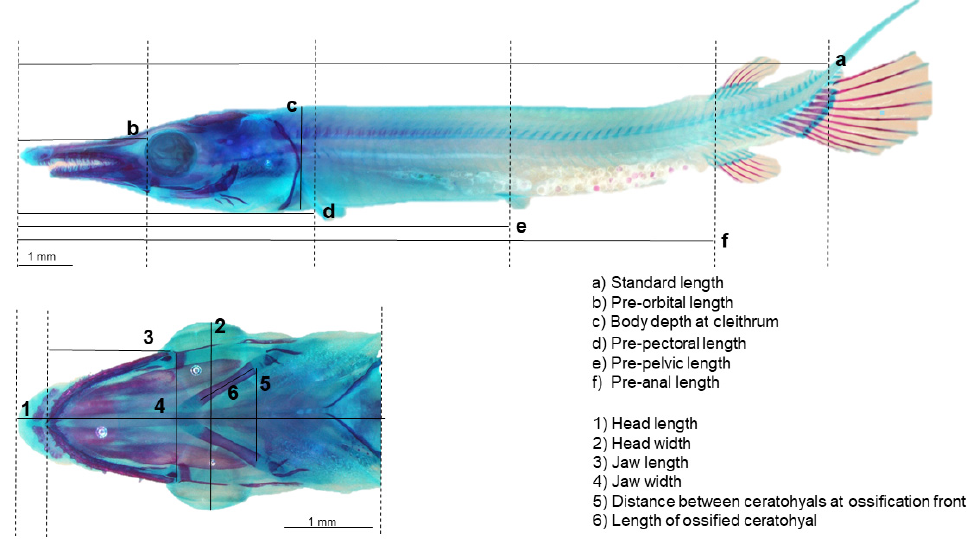
Figure 6. Different biometric measurements performed in the body and head of tropical gar ( Atractosteus tropicus ) larvae when embryos were incubated at different thermal regimens.